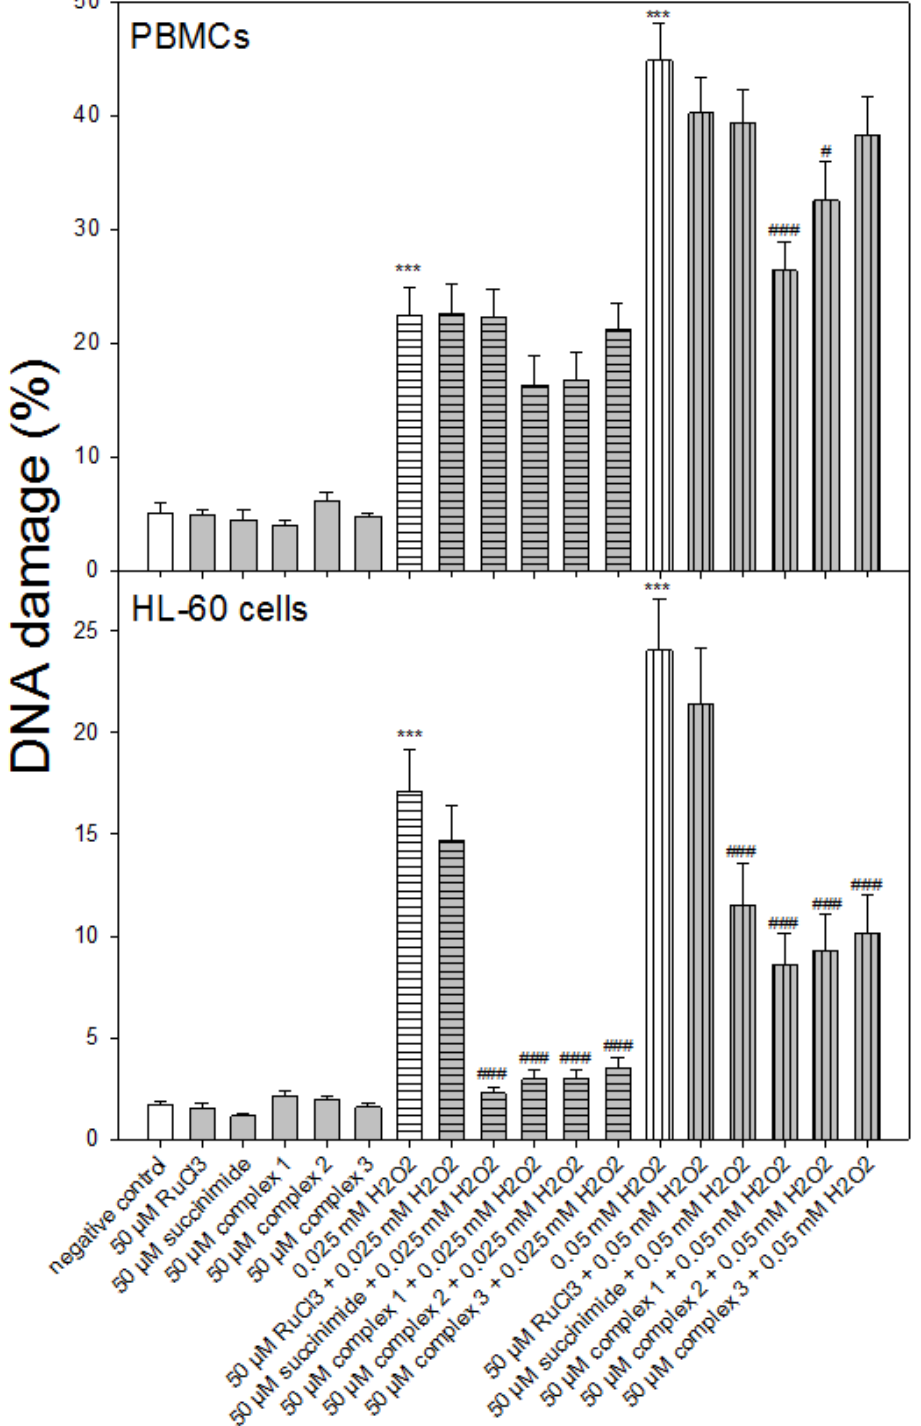
Figure 3. Effect of ruthenium complexes 1 – 3 at 50 µ M on H 2 O 2 -induced DNA damage in PBMCs and HL-60. The figures show mean results ± SEM, n = 100; *** p < 0.001 vs. negative control; # p < 0.05, ### p < 0.001 vs. H 2 O 2 .